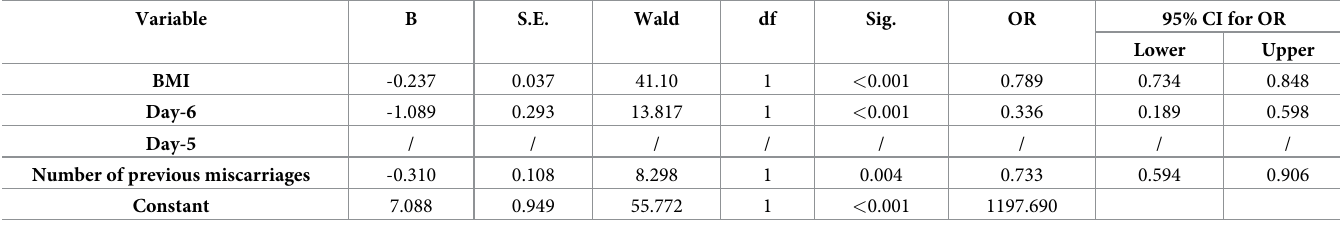
Table 4. Binary Logistic Regression Model using Forward Stepwise Model (Likelihood